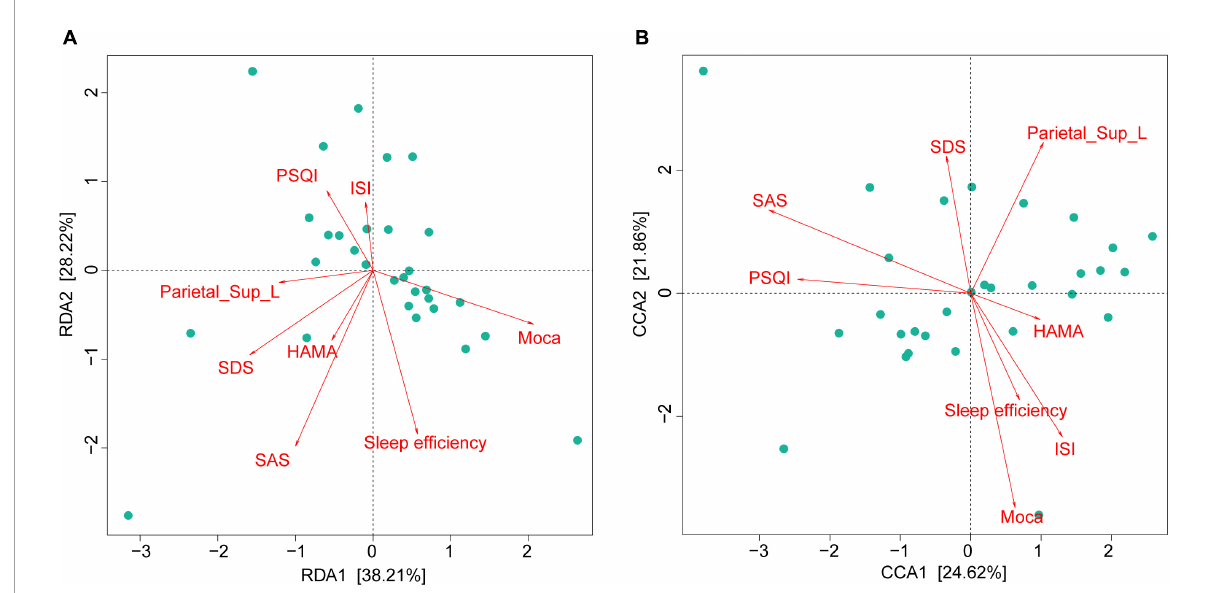
FIGURE5 Gut microbiota composition strongly associated with neuropsychological performances in CI patients. RDA (at the phylum level) and CCA (at the genus level) demonstrated that 38.21% (A) and 24.62% (B) of the variance could be interpreted by seven environmental factors (in other words: neuropsychological performances). CI, chronic insomnia; RDA, redundancy analysis; CCA, canonical correspondence analysis.